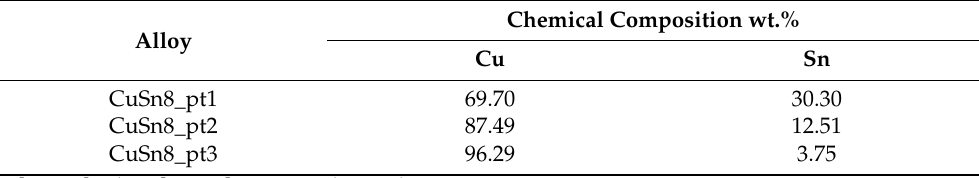
Table 4. Chemical composition EDS wt.% of CuSn8 alloy for the Figure 6a image.